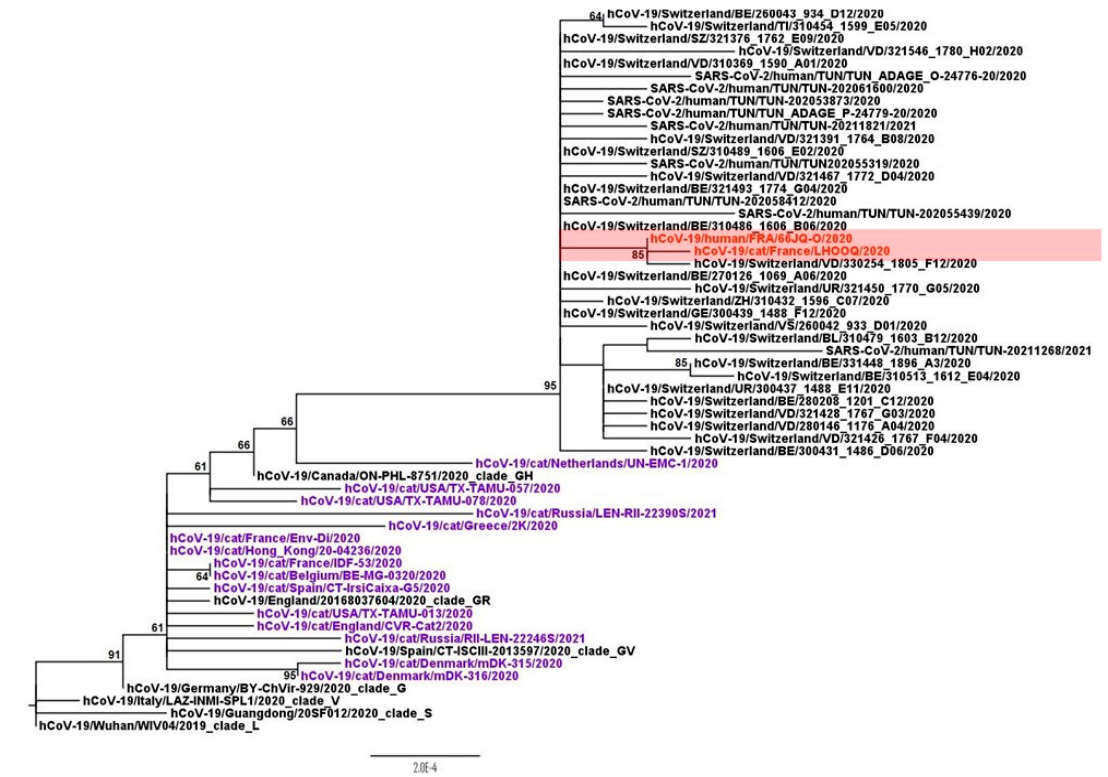
Figure 1. Whole-genome maximum likelihood phylogenetic tree of SARS-CoV-2. The viruses in Table 1, sequence from case 3, and the owner-derived sequence are both labelled in red. Other feline-derived viral sequences are labeled in purple. Bootstrap supports >60% are indicated next to the nodes; the scale bar indicates the numbers of nucleotide substitutions per site. The strain hCoV-19/Wuhan/WIV04/2019 was used as the outgroup.